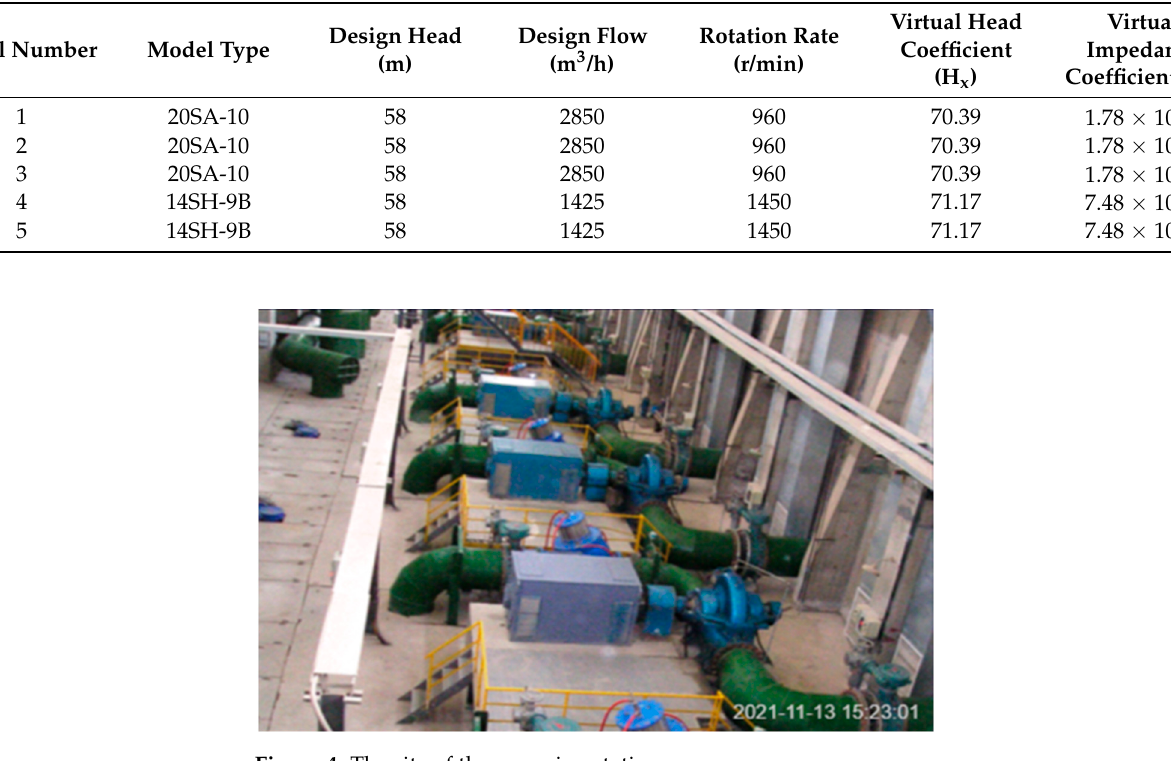
Figure 4. The site of the pumping station.